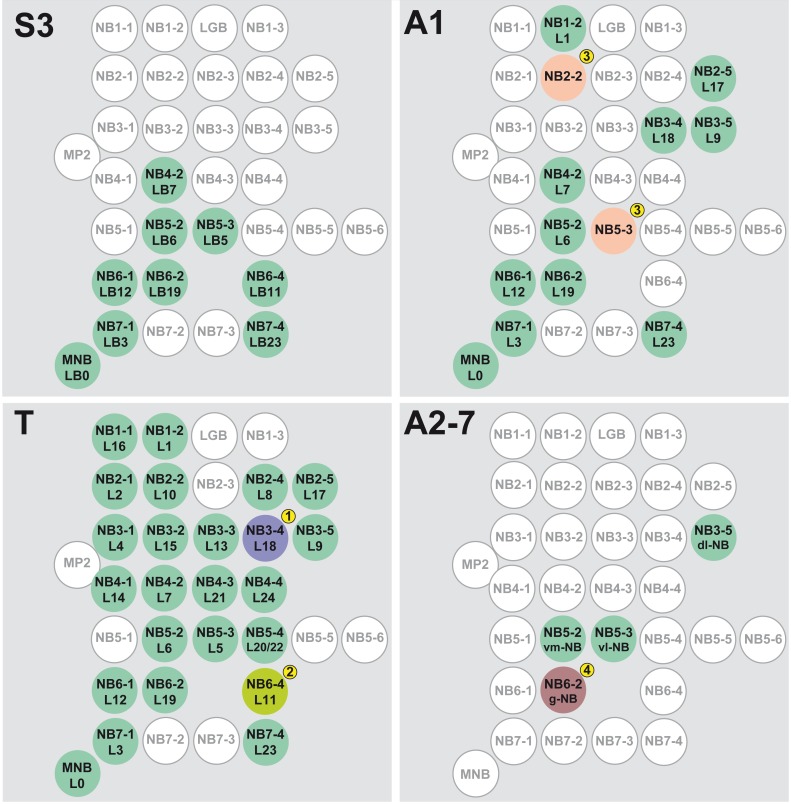
Segment-specific pattern and identities of embryonic neuroblasts, which are reactivated in the larva.Right hemineuromeres of the indicated segments are schematically shown. In each NB its embryonic name (upper row) according to Broadus et al. (Broadus et al., 1995) and Doe (Doe, 1992) and its postembryonic cell lineage (lower row) according to Brown and Truman (Brown and Truman, 2009), Kuert et al. (Kuert et al., 2014) and Truman et al. (Truman et al., 2004) are indicated, except for A2-A7, where the lower row indicates the name of the postembryonic progenitor according to Truman and Bate (Truman and Bate, 1988). NBs which are reactivated in the larva, are highlighted in green; those which are mitotically inactive are white; other colours mark NBs with segment-specific characteristics: (1) Lineage 18 was not identified in T1. (2) Lineage 11 was not identified in T3. (3) NB2-2 and NB5-3 only form a few secondary neurons in A1 and reveal PCD within their lineage. (4) NB6-2 is only reactivated in A2, but not posterior to it.